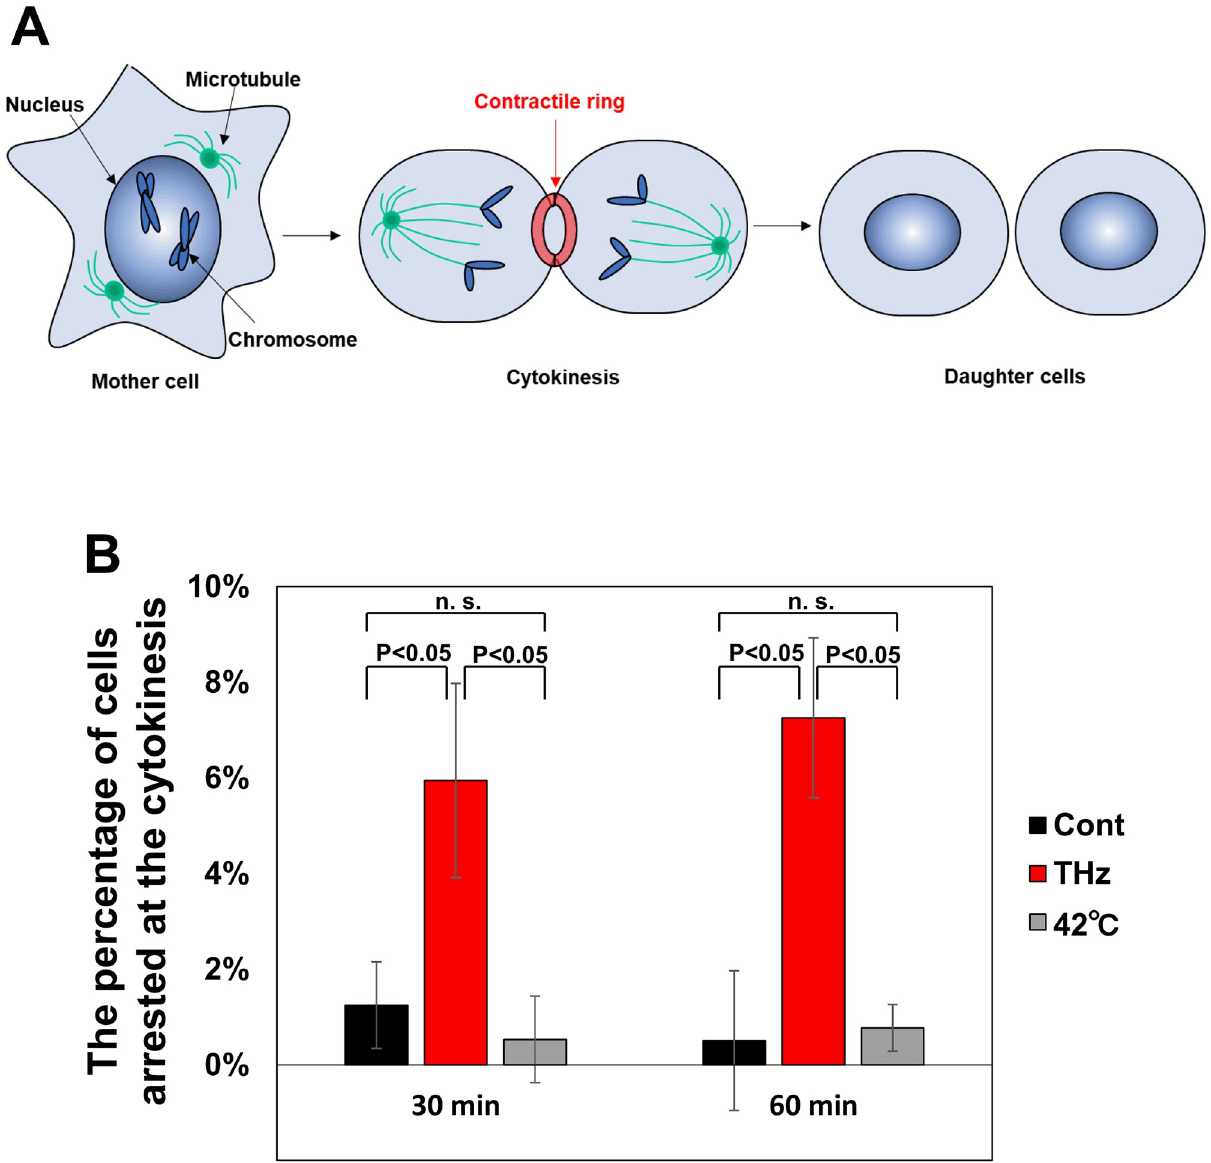
Fig 2. THz irradiation halts cytokinesis. (A) Schematic representation of mitotic progression. In the process of mitosis, actin polymerization is induced to make the contractile ring, which is required for starting the division of the mother cell into two daughter cells. Then, the contractile ring is squeezed and completes cell division. Cytokinesis is generally completed within 15 minutes. (B) Percentage of cells arrested at cytokinesis. The cell cycle was synchronized to the mitosis phase with 25 μ g/ml nocodazole before each experiment. Nocodazole interferes with the polymerization of microtubules and arrests the initial step of mitosis. Cells were determined to be arrested at cytokinesis when the contractile ring was retained for more than 30 minutes after the release from nocodazole. The error bars show the standard deviation of three independent experiments. More than 184 cells were measured in each